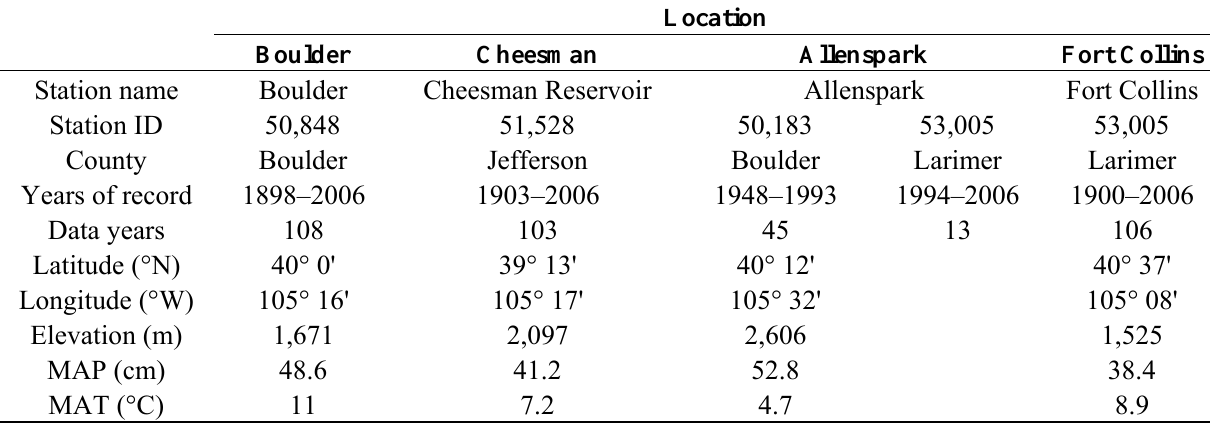
Table 1. Weather stations with daily weather data to be used in the DAYCENT model [17].